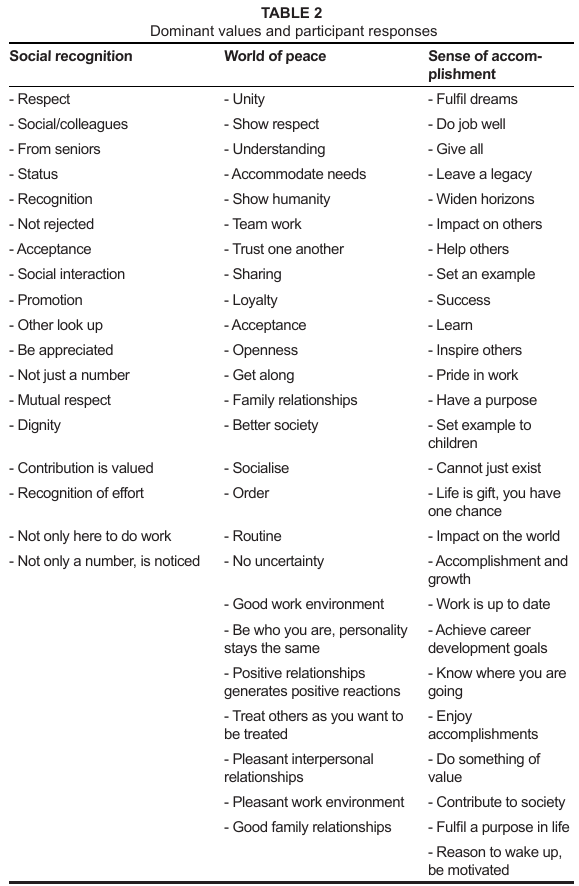
Table 2 lists the participant responses related to each of the three dominant values: social recognition, a sense of accomplishment and a world of peace.